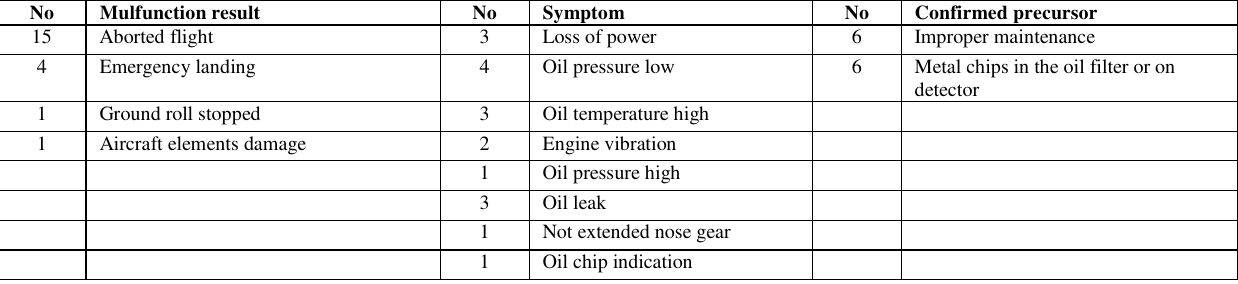
Table 8. Confirmed roots of the piston engines failures coded in the ATA 79 chapter which caused aviation